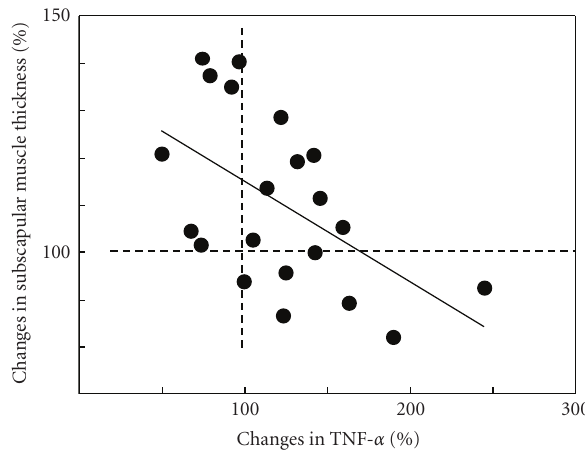
Figure 1: Correlation between percent change in TNF- α and subscapular muscle thickness r = − 0 . 54, P = . 011. Dotted lines (100%) represent the baseline value for each subject. A greater absolute increase would appear above 100%, and a greater absolute decrease would appear below 100%. Percentage change is calculated as [postvalues – prevalues]/[prevalues] ×